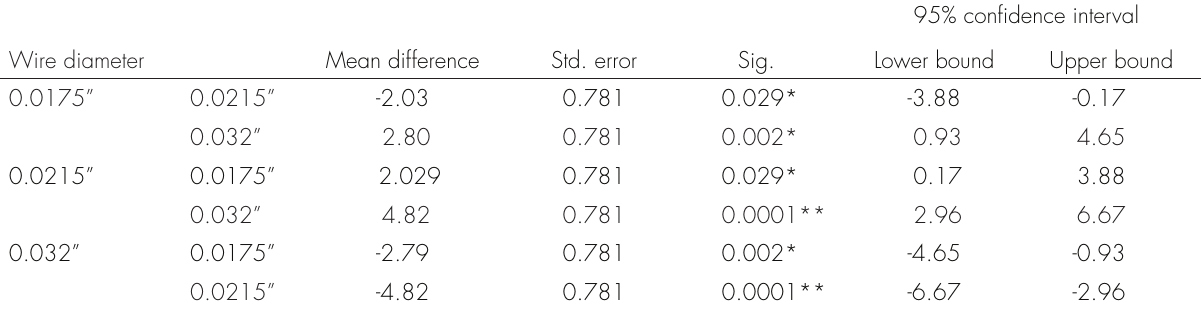
Table III. Post hoc analysis for wire diameter effect using Tukey HSD test. Dependent variable: shear bond strength.